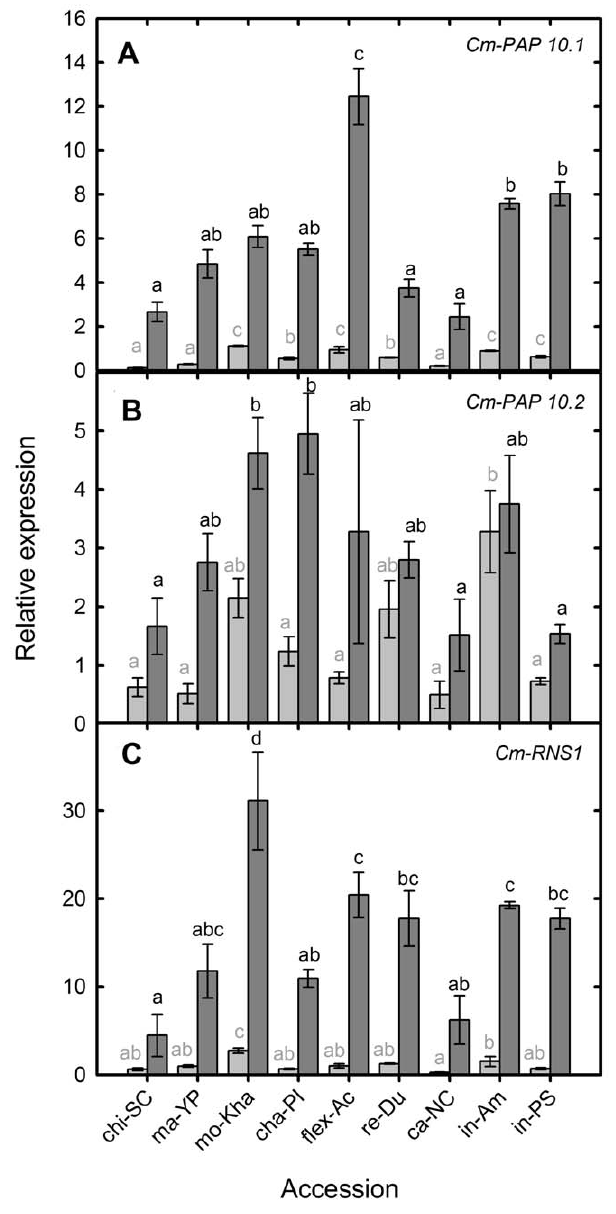
Figure 4. Root transcript abundance for Cm-PAP10.1 , Cm- PAP10.2 , Cm-RNS1 in nine melon accessions under P replete and P starved conditions. Relative transcript abundance for (a) Cm- PAP10.1 [MU46092], (b) Cm-PAP10.2 [MU50216], (c) Cm-RNS1 [MU47003] in different melon accessions grown hydroponically with a full nutrient solution (Control, light grey) or nutrient solution containing no phosphate (NoP, dark grey) for 21 d. Transcript abundance was measured using quantitative PCR (Q-PCR) and expressed relative to that of the housekeeping gene ( Cm-Ubiquitin ). Grey bars with the same grey letter are not significant different at P , 0.05 by Newmans Keuls multiple range test. doi:10.1371/journal.pone.0035387.g004 (Figure 5A). Ma-YP and ca-NC showed lower levels of expression under NoP (4.38 and 4.72 respectively) and re-Du had the highest level of expression (12.38) followed by in-PS. Under the NoP condition the expression of Cm-transferase increased on average 7- fold across accessions compared with the control treatment